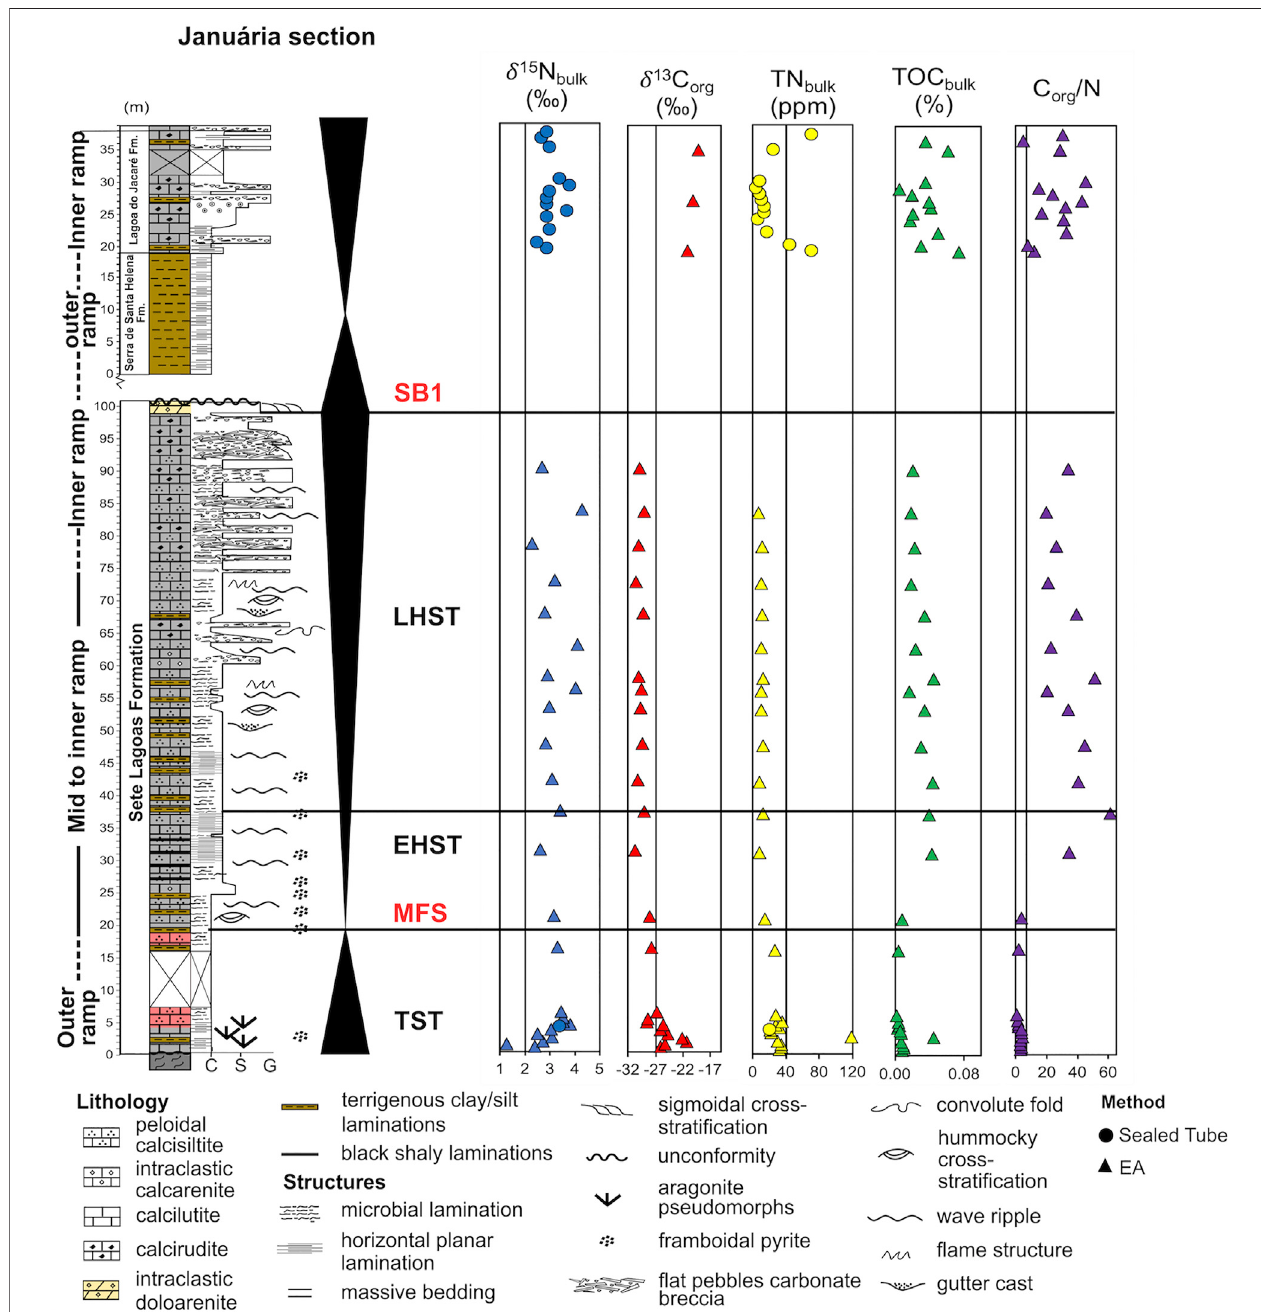
FIGURE 4 | Janu (cid:1) aria section: Depositional environments, lithologies, structures and sequence stratigraphy framework. δ 15 N data was obtained in this study and δ 13 C fi xed on the Red fi eld ratio (6.6). System tracts: TST, Transgressive System Tract; org was published by Caetano-Filho et al. (2021). The axis on the C org /N column is MFS,MaximumFloodingSurface;EHST,EarlyHighstandSystemTract;LHST,LateHighstandSystemTract;SB1,SequenceBoundary.Granulometryscale:C,clay;S, sand; G, gravel. Adapted after Caetano-Filho et al.